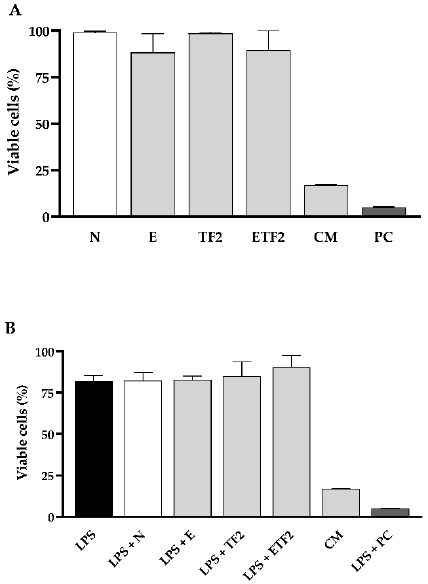
Figure 3. Percentage of cell viability of bone-marrow-derived macrophages (BMDMs) by MTT assay after treatment with each formulation. ( A ) BMDMs were not previously stimulated and ( B ) BMDMs were stimulated with lipopolysaccharide (LPS, 1 μg mL −1 ) for 4 h and then exposed to N: formulation without fluoride (F), sodium trimetaphosphate (TMP) and pomegranate peel extract (PPE); E: formulation with 3% PPE; TF2: formulation with 0.3% TMP + 225 ppmF ; ETF2: formulation with 3% PPE + 0.3% TMP + 225 ppmF ; CM: essential oil commercial mouthwash; PC (positive control, triton) for 2 h.